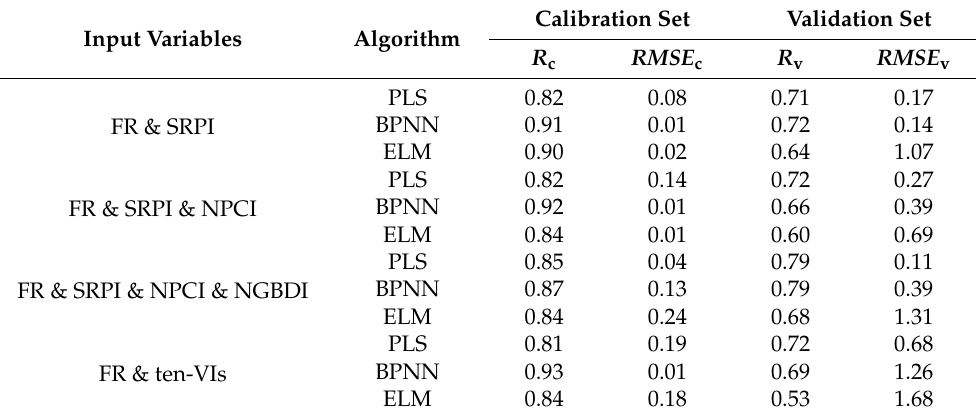
Table 8. CNC prediction results with PLS, BPNN and ELM based on different input variables (FR represents five-band reflectance).